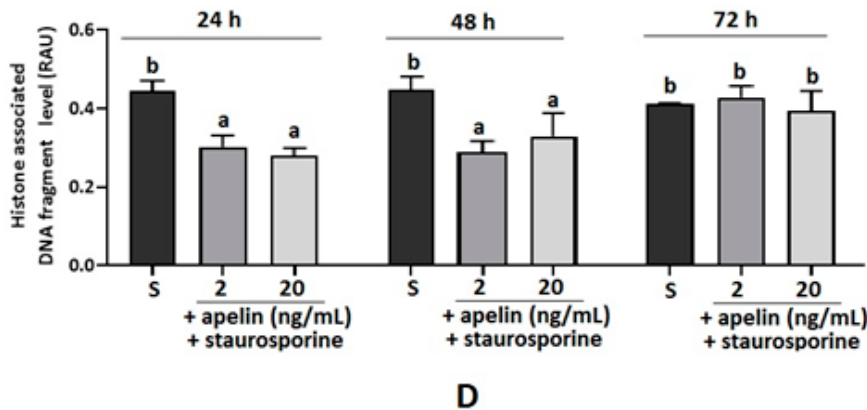
Figure 2. Effect of apelin on caspase 3 and 7 activity and histone-associated DNA fragment level in BeWo cells. The cells were incubated with 2 and 20 ng/mL of apelin alone or in combination with 0.1 µL/mL staurosporine for 24, 48 and 72 h, after which caspase 3 and 7 activity ( A , B ) was analysed using the Caspase-Glo 3/7 assay or the level of histone-associated DNA fragments ( C , D ) by the Cell Death Detection ELISA kit. Experiments were independently performed and repeated three times ( n = 3). The data are arranged as means ± SEM. Different letters indicate significant differences ( p < 0.05) among groups; Control ( C ), Staurosporine (S), Relative Luminescence Unit (RLU), Relative Absorbance Unit (RAU).